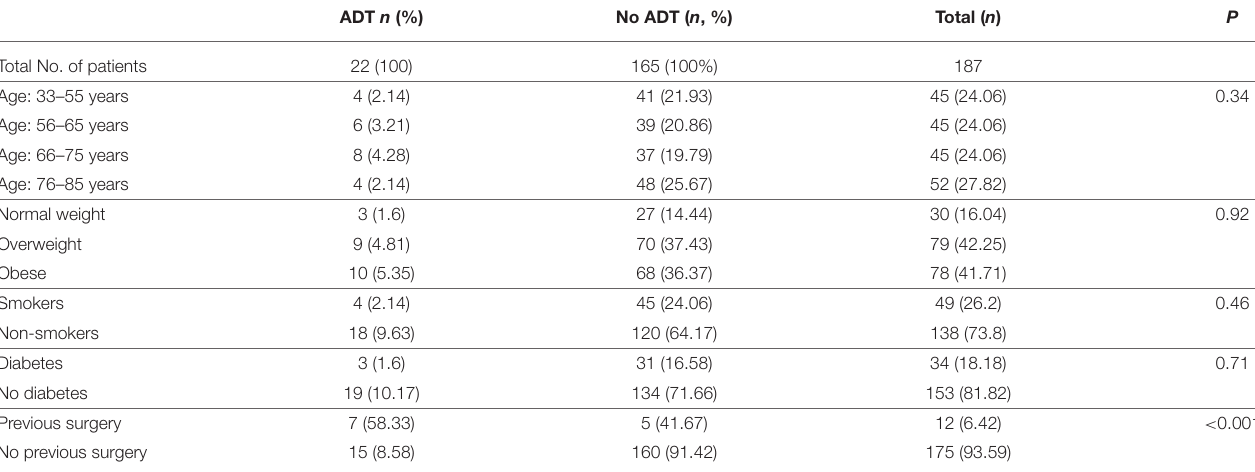
TABLE 2 | Rate of accidental dural tears (ADTs) in total and by patient subgroups age, BMI groups, smoking status, diabetes, and previous surgery. ADT n (%) No ADT ( n , %) Total ( n ) P Total No. of patients 22